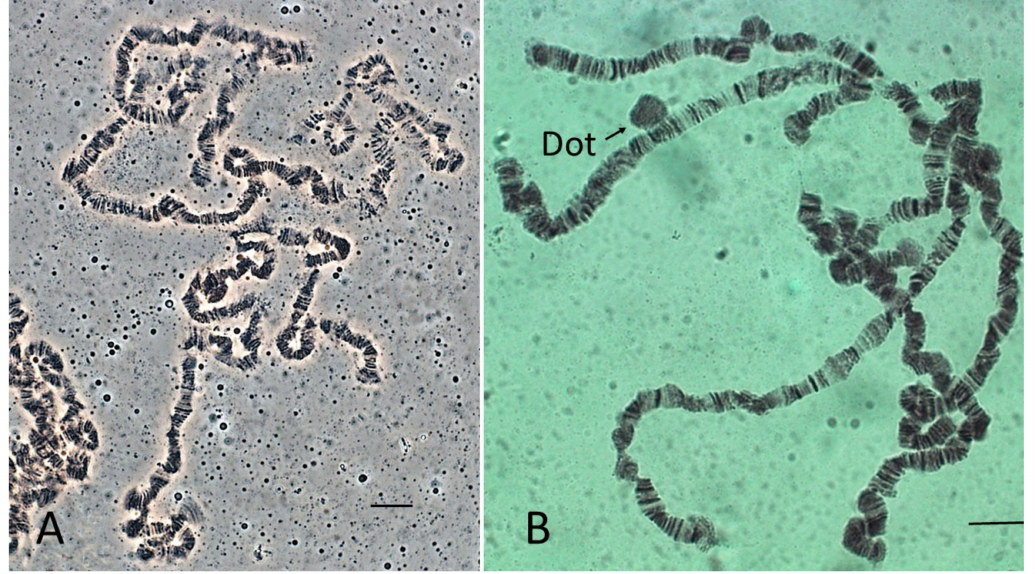
Figure 3. ( A ) Scaptodrosophila bryani polytene set. ( B ) Scaptodrosophila cancellata polytene set. Presumed ‘dot’ indicated. Bar = 10 µ m.